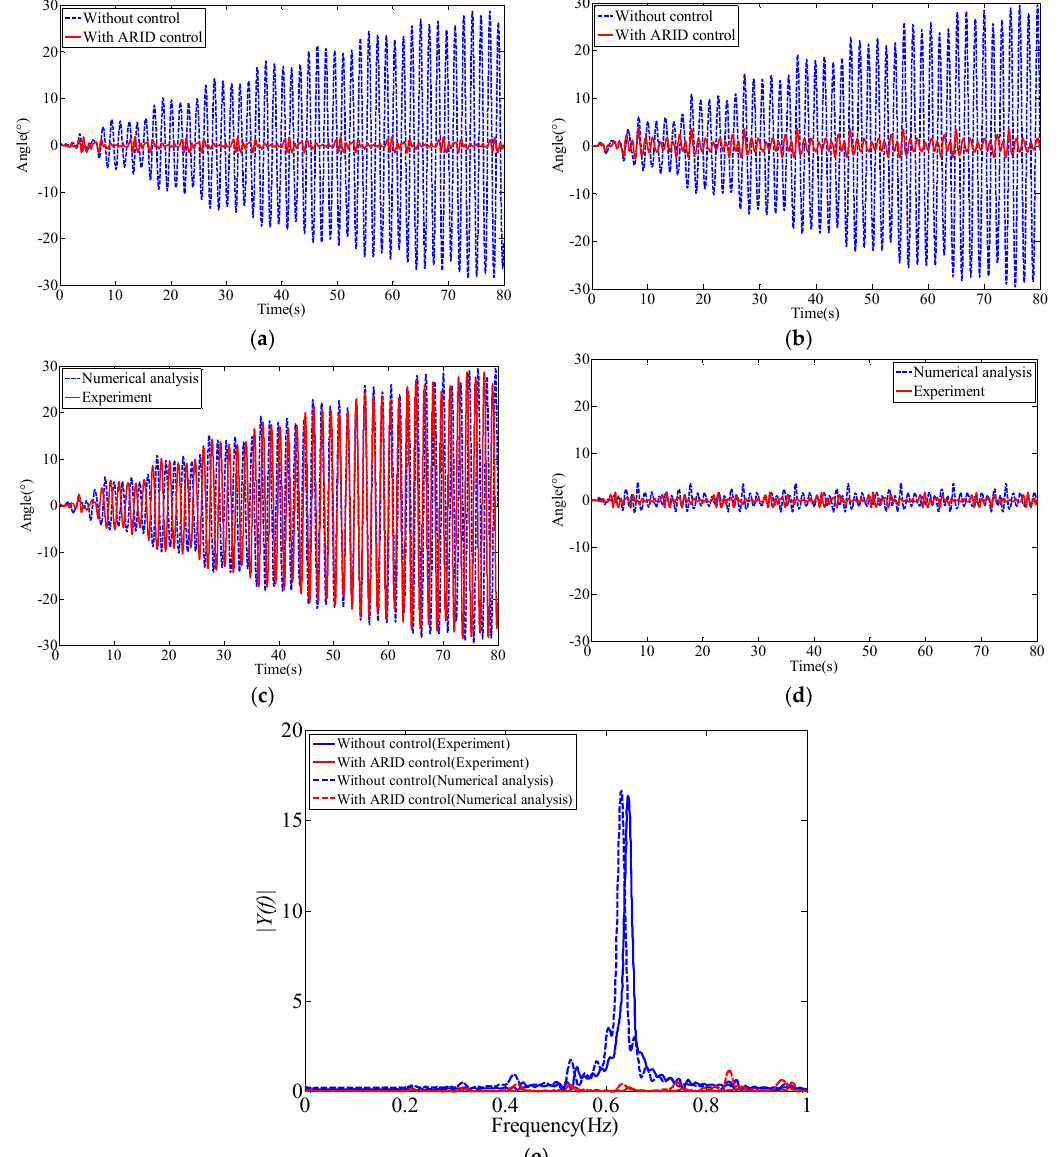
Figure 13. The experimental and numerical results of the structure with the ARID system: ( a ) Results of experiments; ( b ) results of numerical analyses; ( c ) experimental and numerical results of the structure without control; ( d ) experimental and numerical results of the structure with ARID control; ( e ) amplitude–frequency curve.